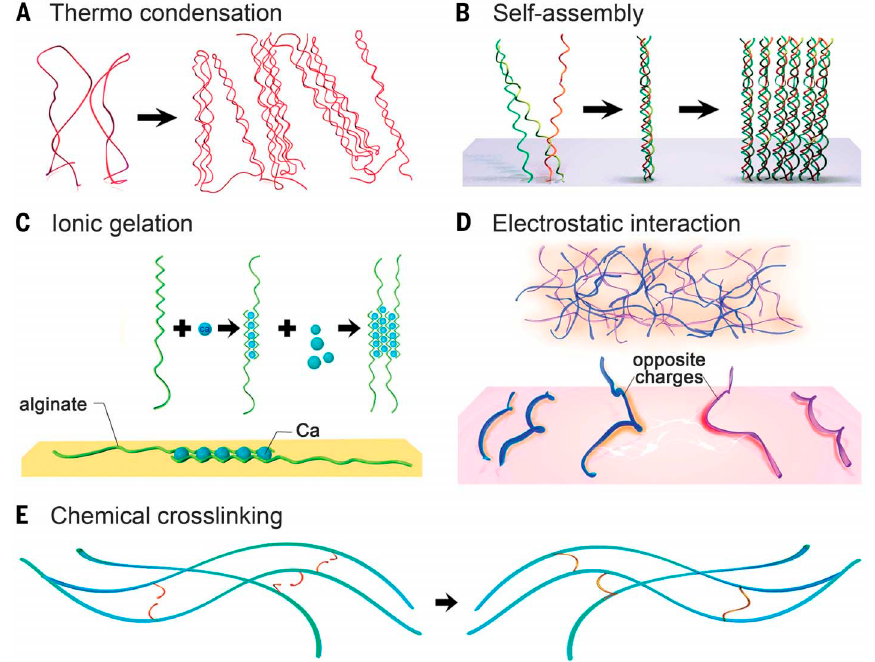
Figure 1. Crosslinking of hydrogels. ( A ) Thermally induced entanglement of polymer chains; ( B ) molecular self-assembly; ( C ) ionic gelation; ( D ) electrostatic interaction; ( E ) chemical crosslinking. Reproduced with permission from [7], copyright 2016 by American Association for the Advancement of Science.